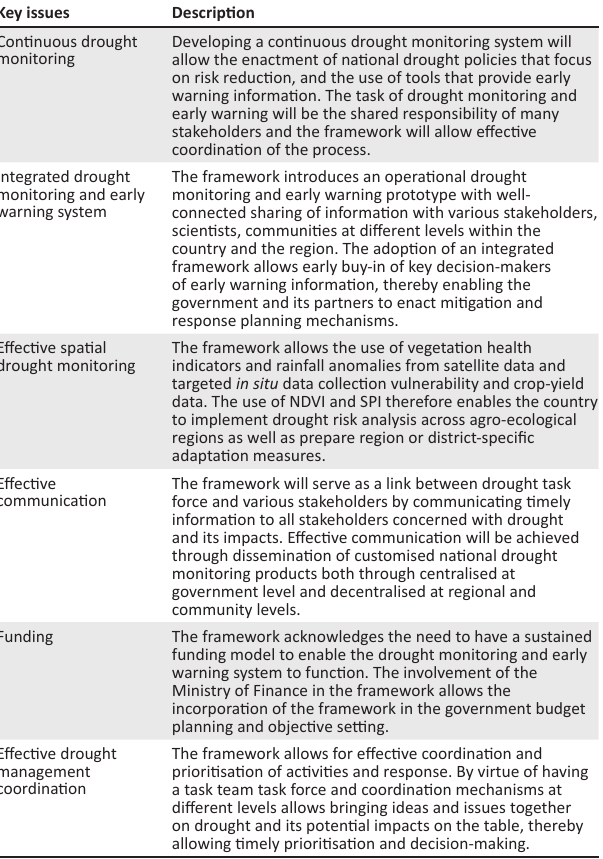
TABLE 4: Practical contributions of institutional framework for drought monitoring and management to existing drought monitoring mechanisms in Eswatini. Key